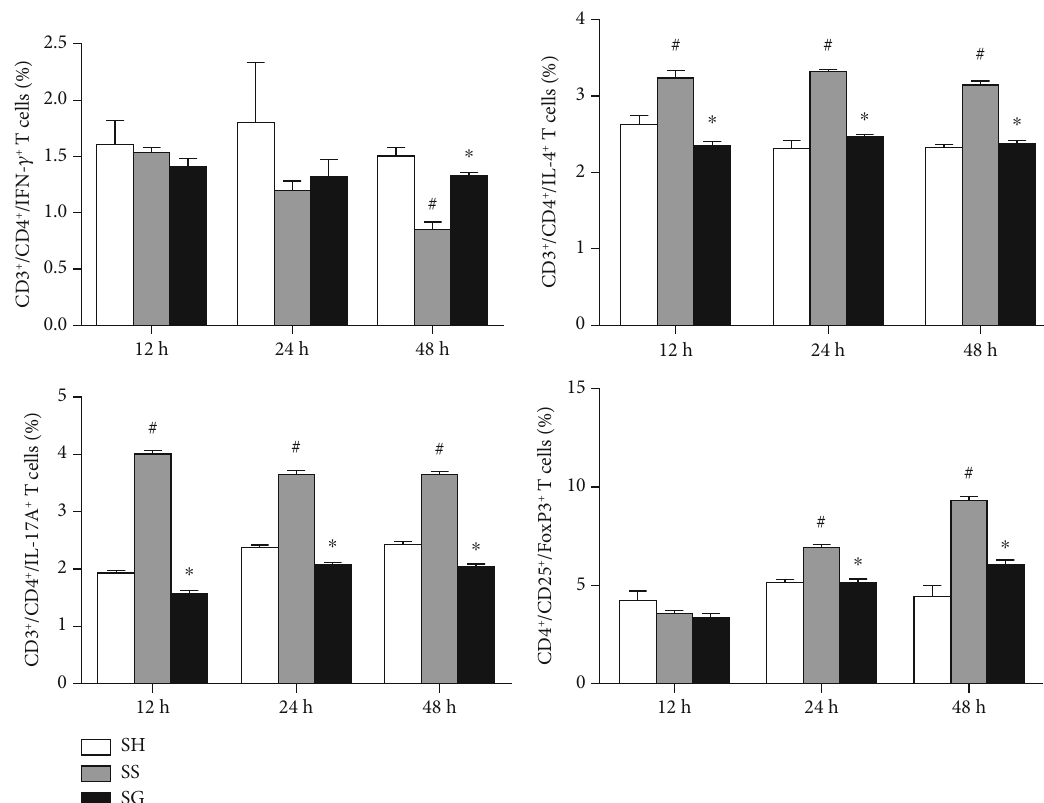
Figure 3: Percentages of helper T (Th) cell subpopulations in blood. Populations of Th cells were determined by CD4 + cells in CD3 + cells. As for subsets of Th cells, percentages of Th1 (interferon- γ -expressing cells), Th2 (interleukin (IL)-4-expressing cells), and Th17 cells (IL-17-expressing cells) among CD4 + lymphocytes were analyzed. Regulatory T (Treg) cells are presented as the percentage of CD25 + Foxp3 + cells among CD4